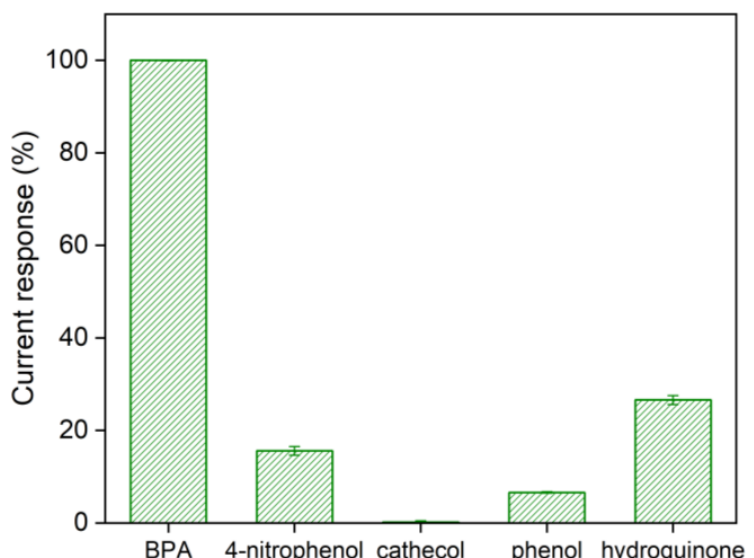
Figure 4. Figure 4. Relative current percentage upon several possible interferents for evaluating the sensor selectivity.